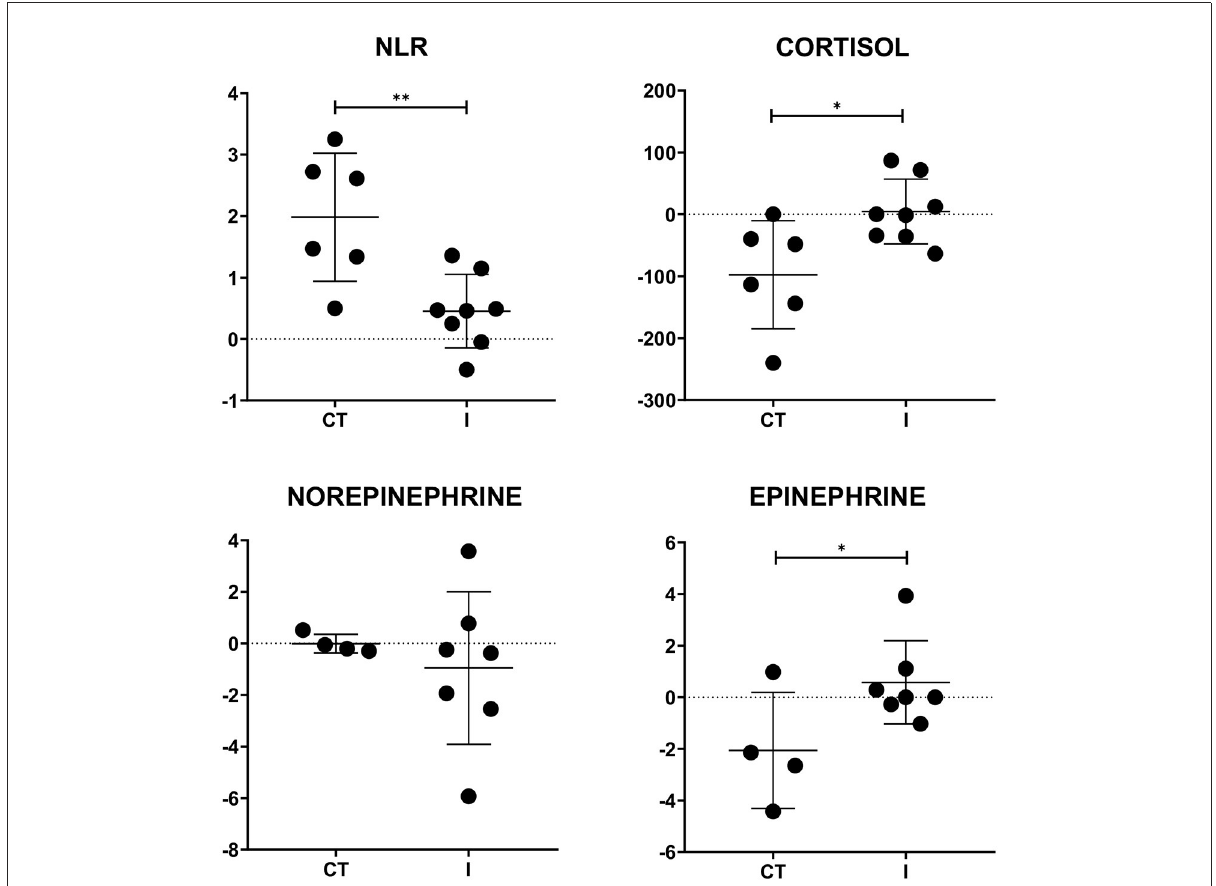
FIGURE2 Slope values of NLR, cortisol, and catecholamines per treatment after 72h. Slopes values of NLR and plasma cortisol were calculated per treatment using values of days 1 and 3. Statistical differences were observed in NLR, cortisol, and epinephrine slopes. A positive slope shows an increase in initial value while a negative one evidences a decrease. t -tests were carried out. Each dot represents a puppy. Mean ± SD. * = P ≤ 0.05; ** = P ≤ 0.01. CT = conventional treatment; I =